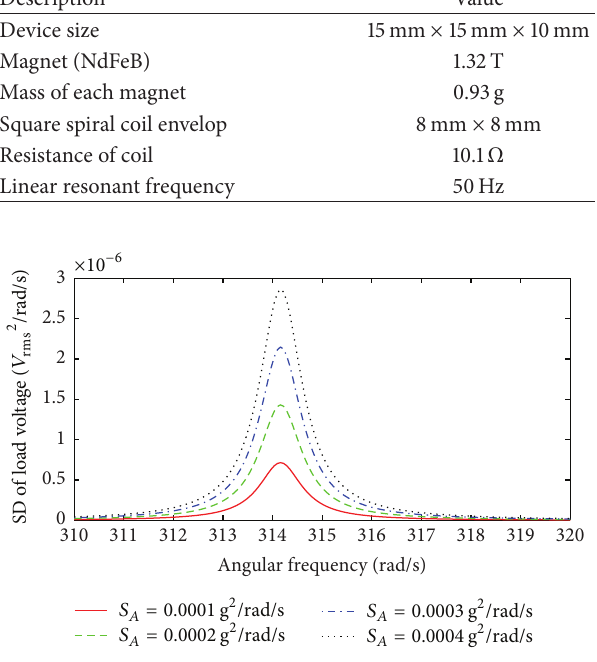
Figure 9: SD of the load voltage as a function of angular frequency forlowlevelsofbroadbandGaussianwhitenoiserandomexcitation; scaling factor 𝜂 = 5 m −2 .